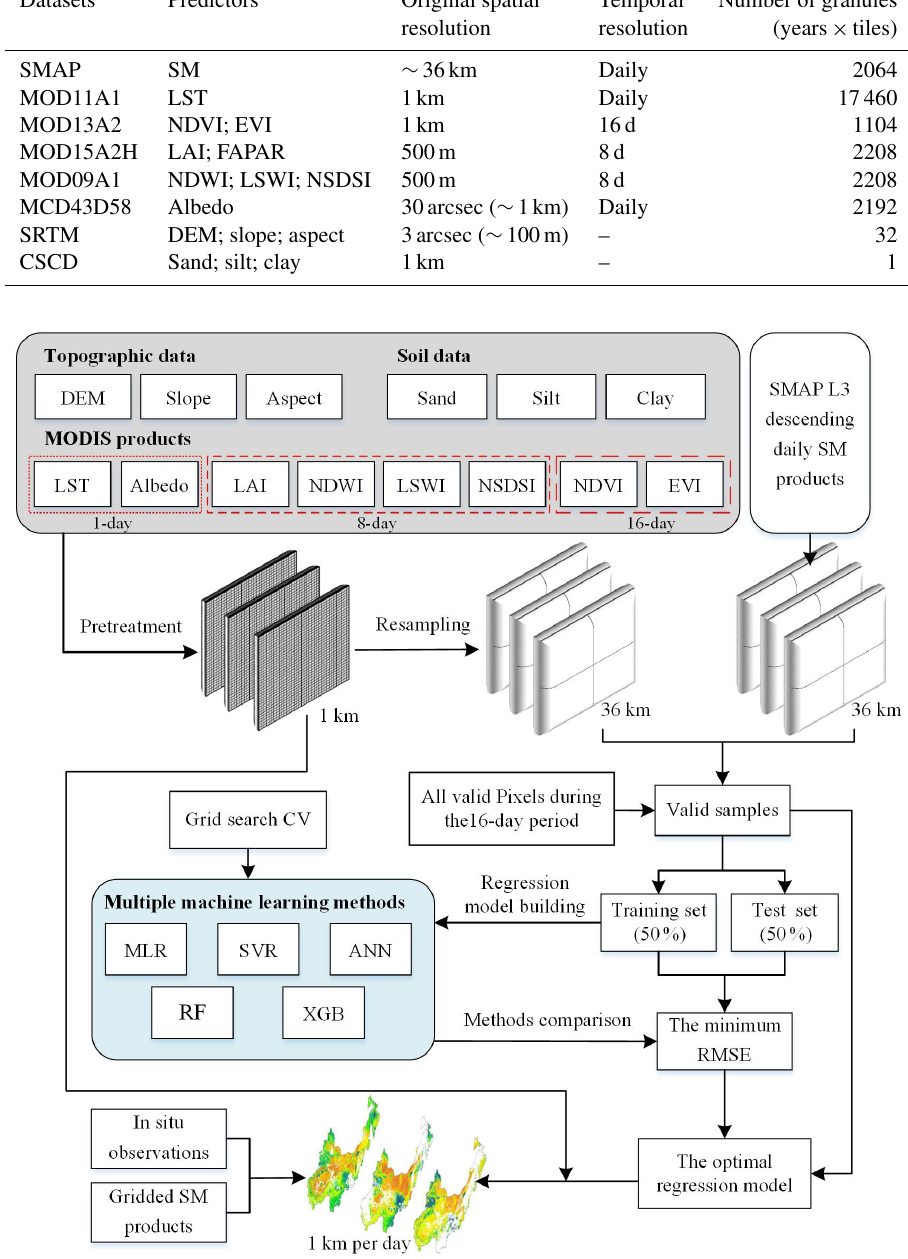
Figure 2. Schematic of the SMAP soil moisture downscaling framework.